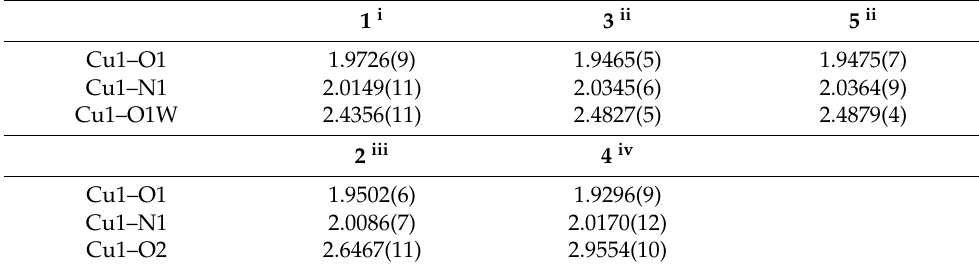
Table 2. Selected bond lengths (Å) for compounds ( 1–5